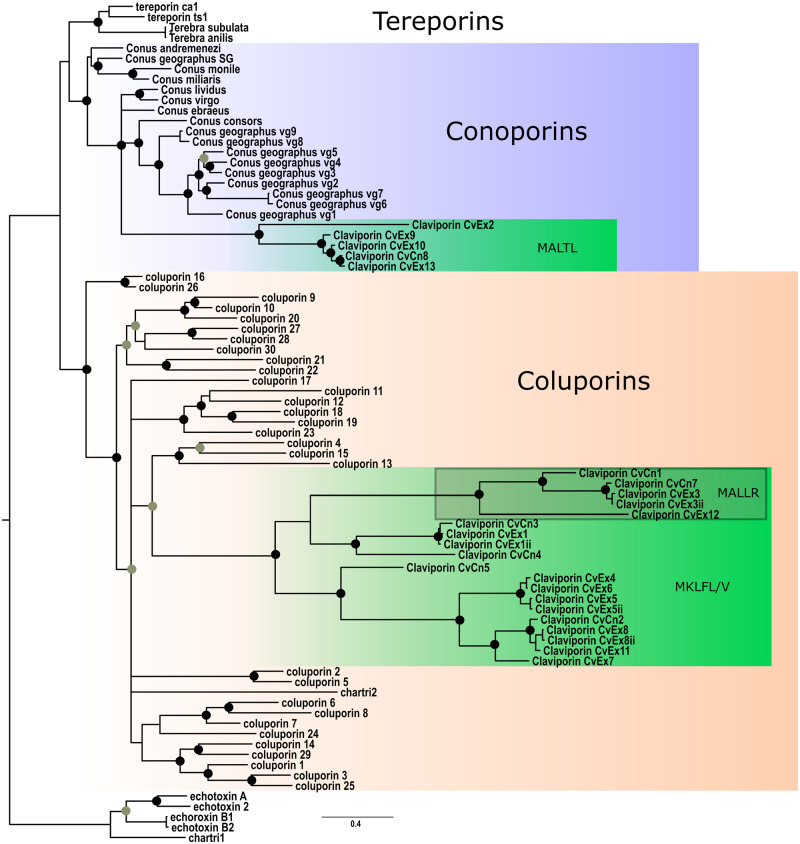
—Bayesian phylogenetic tree of neogastropod porins. Coluporins highlighted with orange, Conoporins—with blue, Clavus porin clusters—with green. Nodes with the Bayesian PP support >0.75 marked with gray circles, and with the PP > 0.9—with black circles.